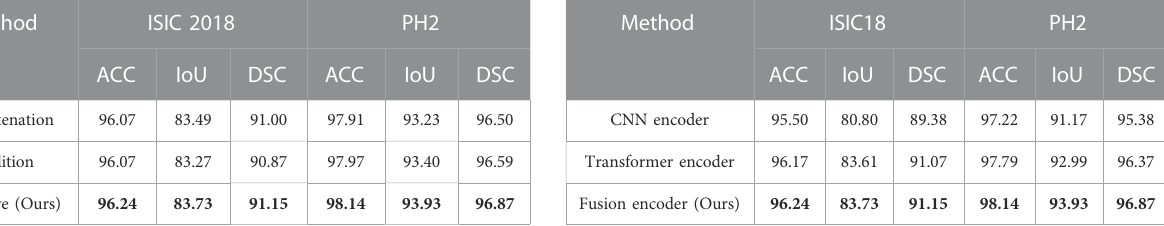
TABLE 2 Quantitative results for the ablation study on the fusion method in ATAC. The best results are shown in bold. Method